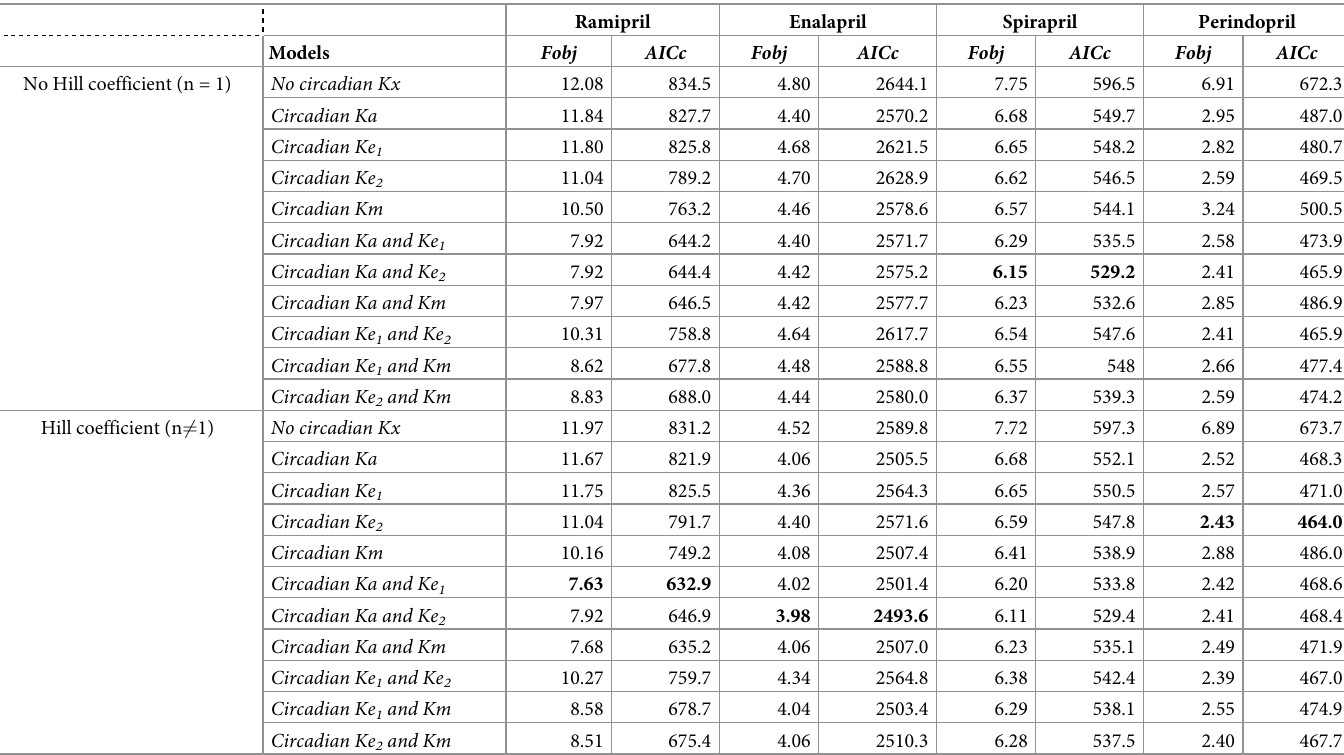
Table 2. Objective function ( Fobj ) and corrected Akaike information criterion ( AICc ) values for prodrug models